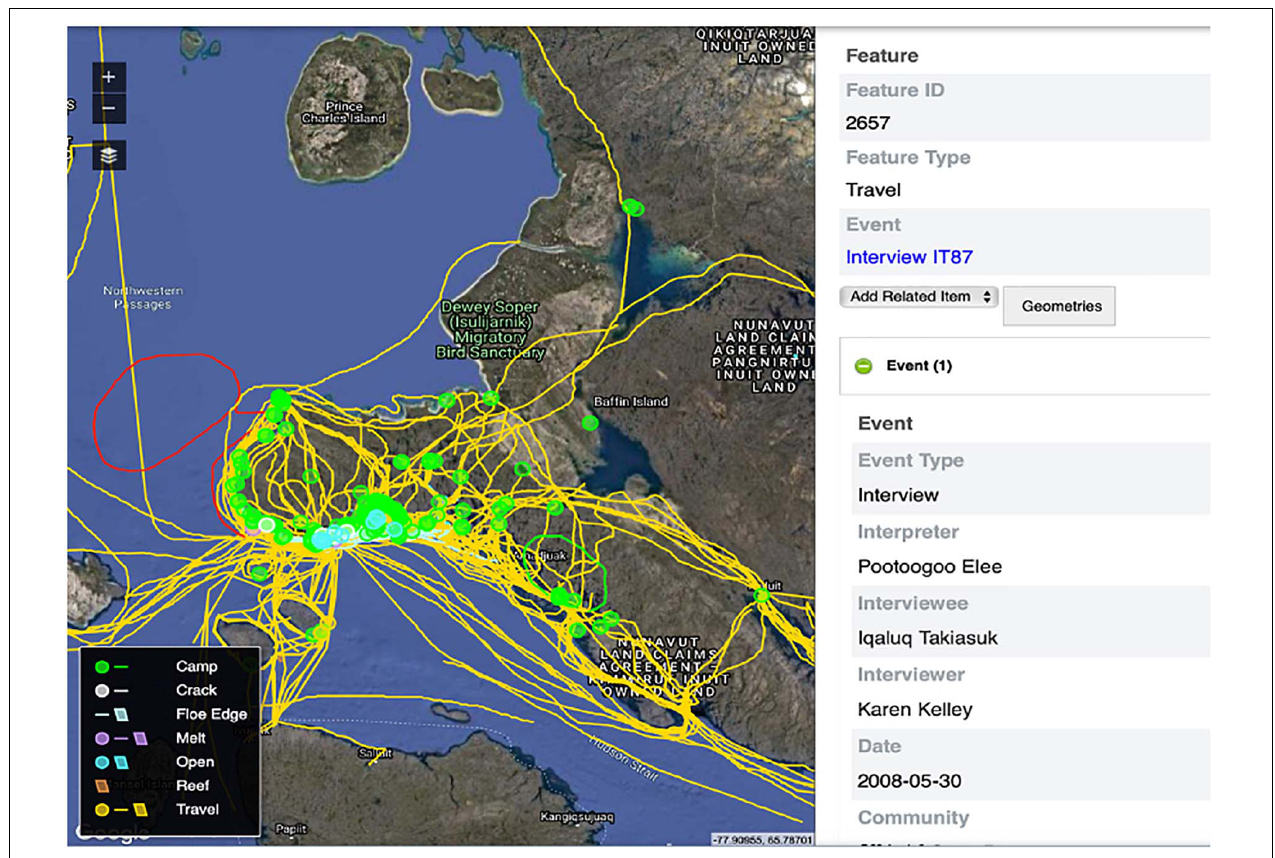
FIGURE 3 | The Siku Sea Ice map is interactive and allow users to click on different features to learn about how the information was collected and where it was collected from. For example, the yellow lines represent travel routes (mapped through participatory mapping sessions). Screenshot from https://sikuatlas.ca/index.html?module=module.sikuatlas.igloolik.sea_ice# on August 10,